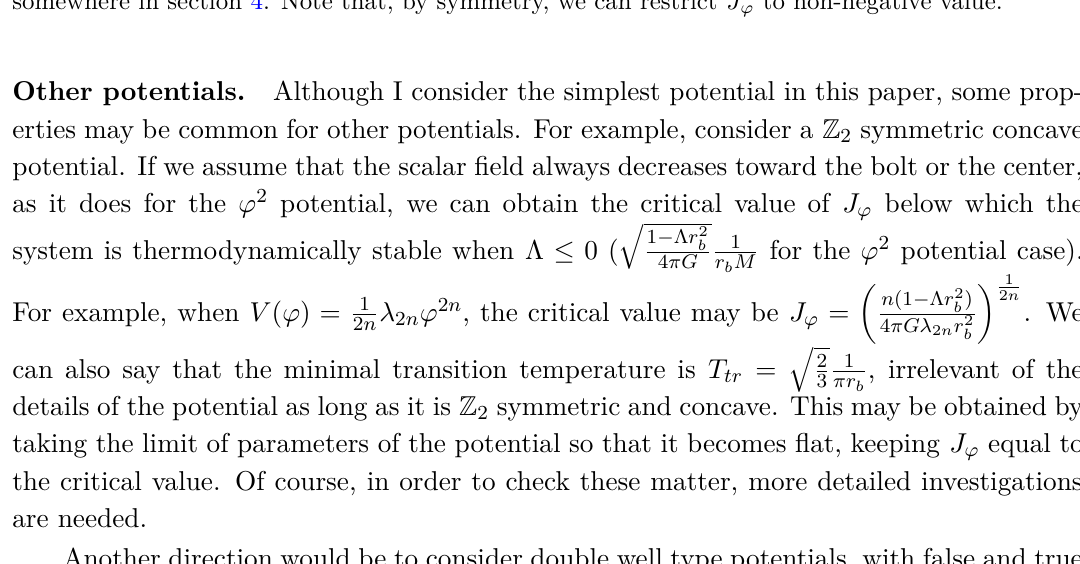
= J ( r Λ , M ) and r = r ( r Λ , M ) are written ϕ,BHcri ϕ,BHcri b , c, max c, max b , J ϕ , to non-negative ϕ